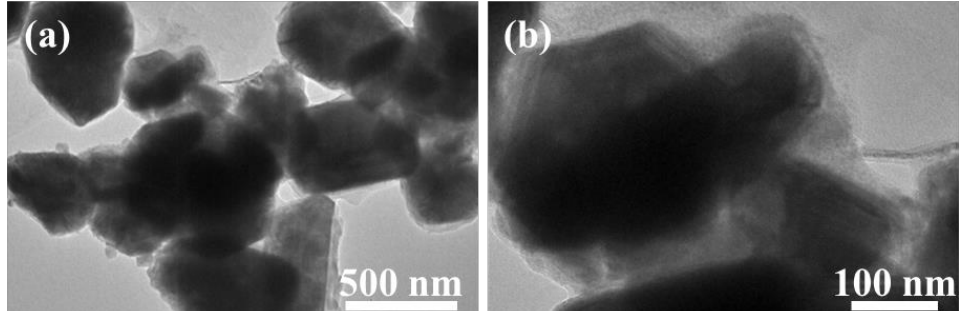
Figure 4. ( a ) Low magnification; ( b ) High magnification HRTEM images of GN@CR-Cu.